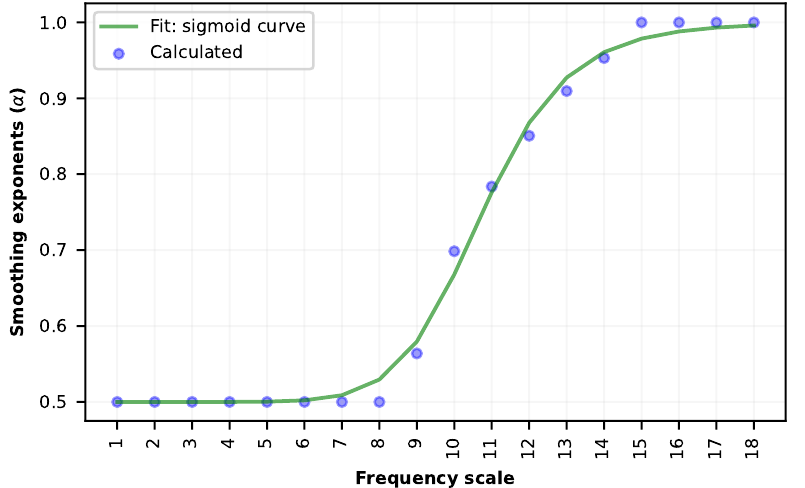
Figure 3. Smoothing exponents for various frequency scales and fitted sigmoid functions based on data from April 2021. The value of 0.5 represents maximum theoretical smoothing effect, while 1.0 represents zero